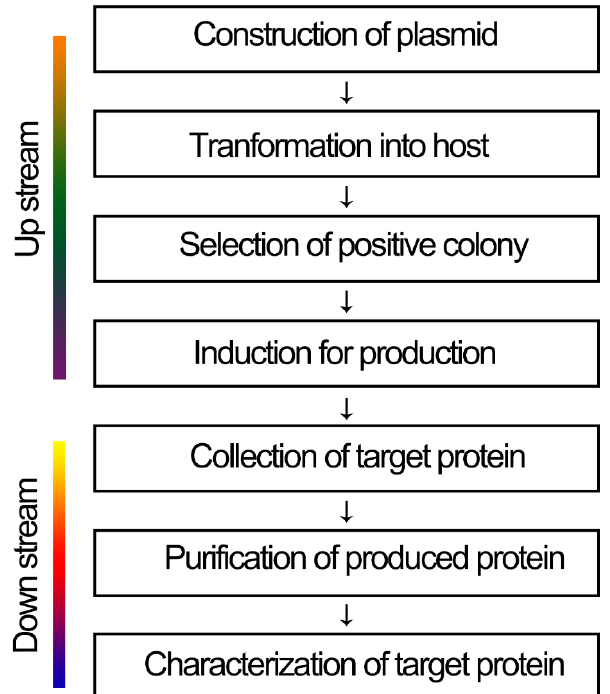
Figure 1. Recombinant protein production process. The process includes upstream and